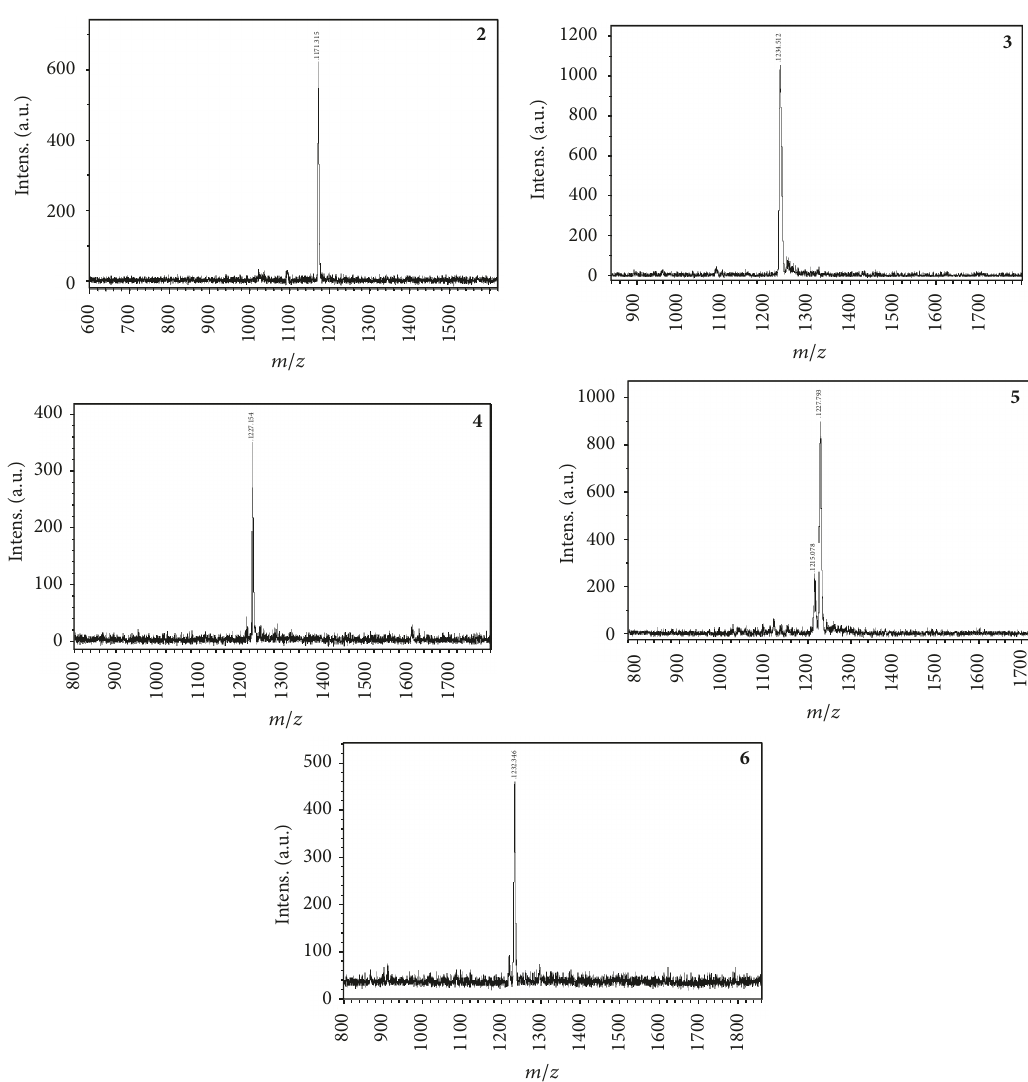
Figure 1: The MALDI-TOF MS spectra of the phthalocyanines ( 2–6